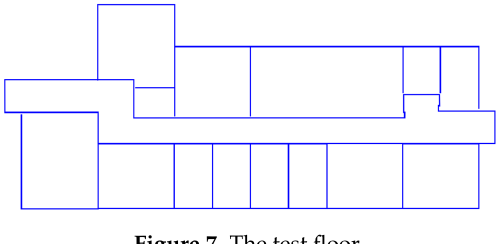
Figure 7. The test